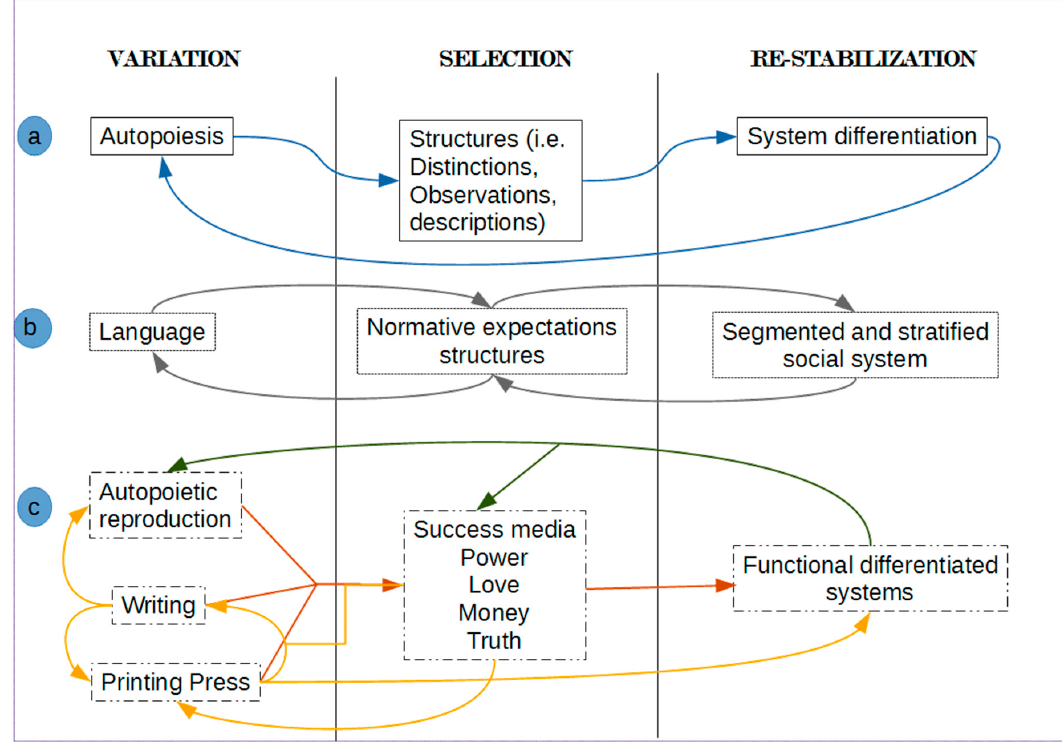
Figure 3. Luhmann ′ s model of socio-cultural evolution: ( a ) Shows the general principles: Autopoiesis is always responsible, one way or another, for variety; selection is performed by systemic structures; and structures that work well persist within the system and reinforce their selectivity; ( b ) accounts for the structural stability of stratified systems; segmented systems, on the other hand, depend on language to perform variations and on interaction systems to select and stabilize at the same time; ( c ) describes modern societies characterized by the primacy of functional systems such as politics, law, education, economy, mass media, and so on; on the other hand, it reflects the complex interdependencies between functional differentiation, communication media and autopoiesis.